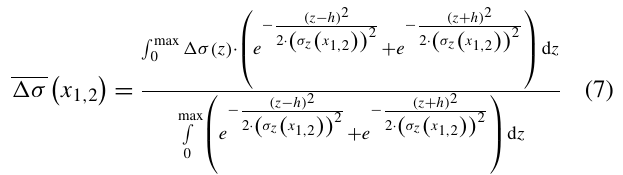
The overscore indicates the mean value of the aforemen- tioned turbulence scenarios with corresponding plume ver- tical widths at each distance, and the errors indicate the differences. Close to the source ( ∼ 1500 m), the relative cross-section uncertainty is ∼ 0 . 6 % and therefore negligi- ble, whereas, at a distance of 4700 m, the relative error is ∼ 3 . 2 % and not negligible in the overall error budget out- lined by Eq.